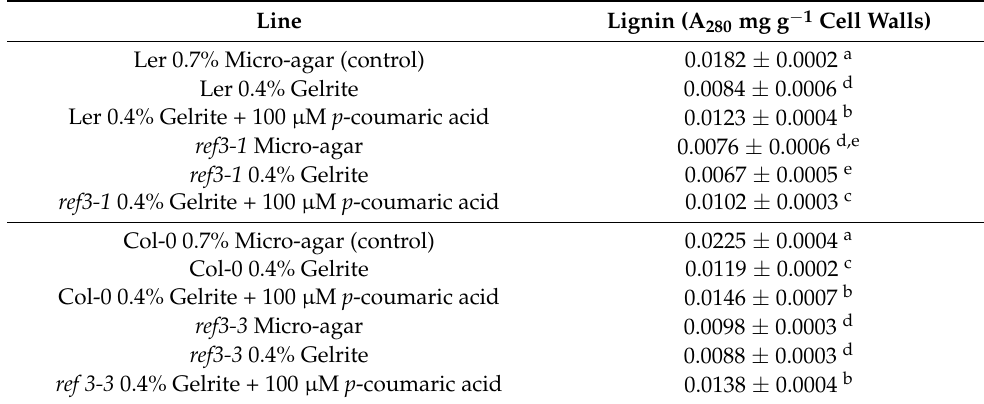
Figure 6. Morphological observations of root growth on Arabidopsis thaliana Col-0, and the less-lignin mutant (ref3-3) . ( A ) Seedlings on Micro-agar (control), ( B ) Seedlings on 0.4% ( w/v ) gelrite, and ( C ) Seedlings cultured on 0.4% ( w/v ) gelrite + 100 µM p -coumaric acid. Bar = 5 mm. Table 1. Total lignin of Arabidopsis thaliana wild-type and less-lignin-mutant seedlings (Ler, Col-0, ref3-1, and ref3-3.